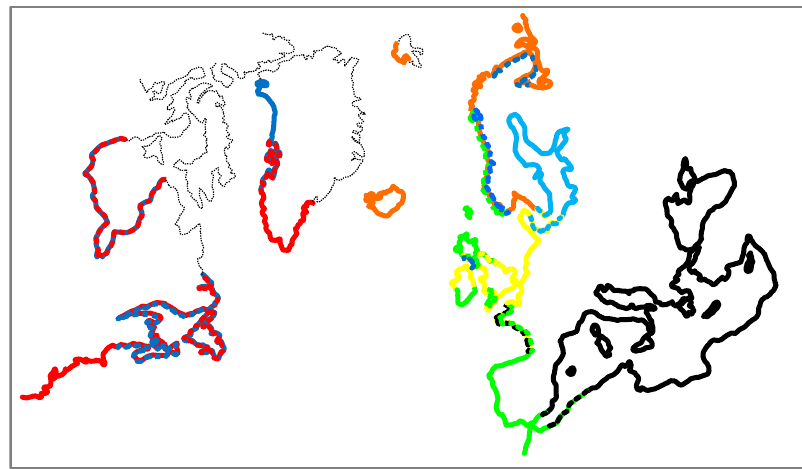
Figure 6. Map of Mytilus lineages distribution in North Atlantics according to original and literature data (see the text for references). M. edulis is depicted by red (American lineage), yellow (West European lineage) and orange (North European M. edulis , the product of intermingling between American and West European lineages), M. trossulus by blue (the Baltic lineage by light blue), M. galloprovincialis by black (Mediterranean lineage) and green (Atlantic lineage).